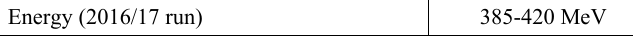
Fig. 1. VEPP-5 Injection Complex layout [1, 2]. Table 1 .VEPP-5 Injection Complex Design Parameters